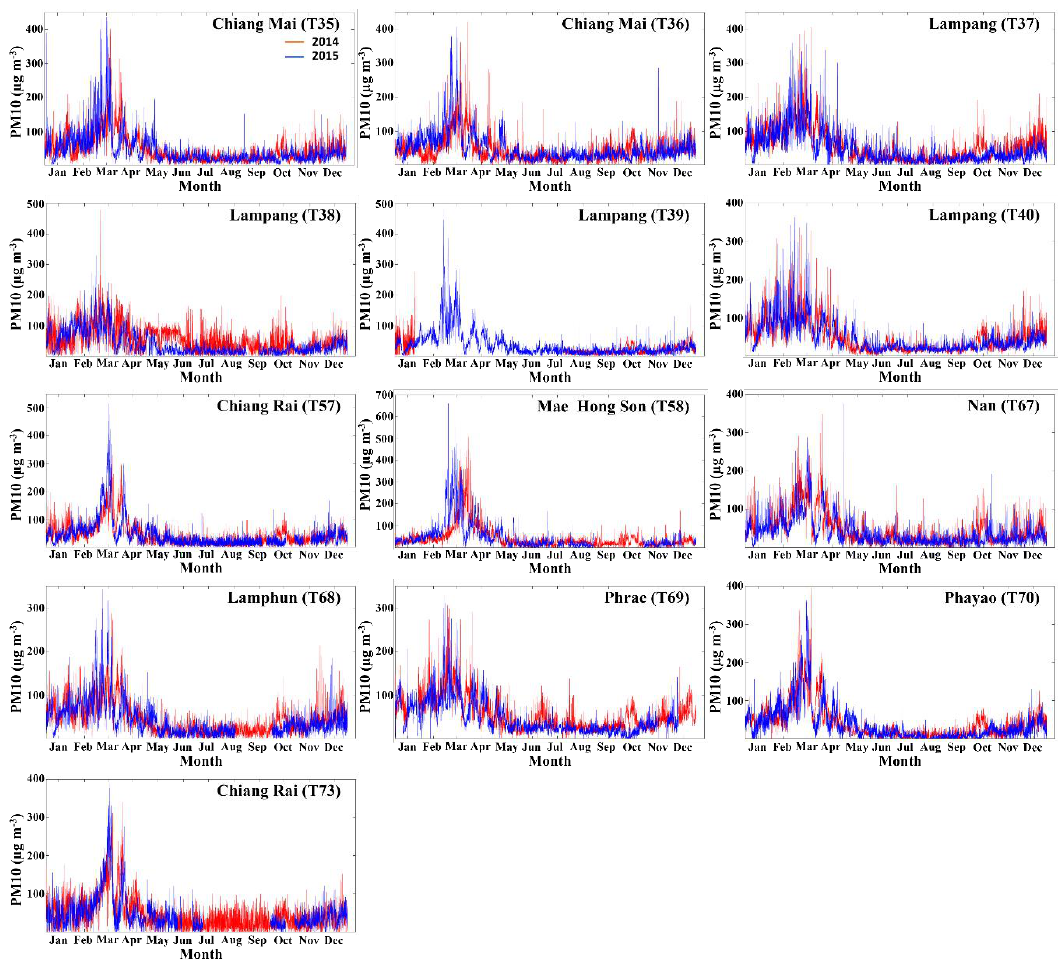
Figure 3. Time series of measured hourly average PM10 concentrations ( µ g m − 3 ) covering the whole years of 2014 (red) and 2015 (blue) for 13 stations employed in this study.